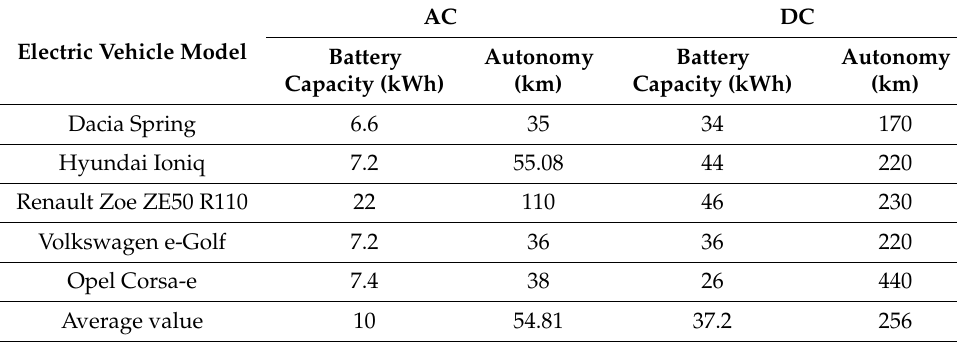
Table 3. Battery capacity and autonomy to charge for 1 h from AC or DC.